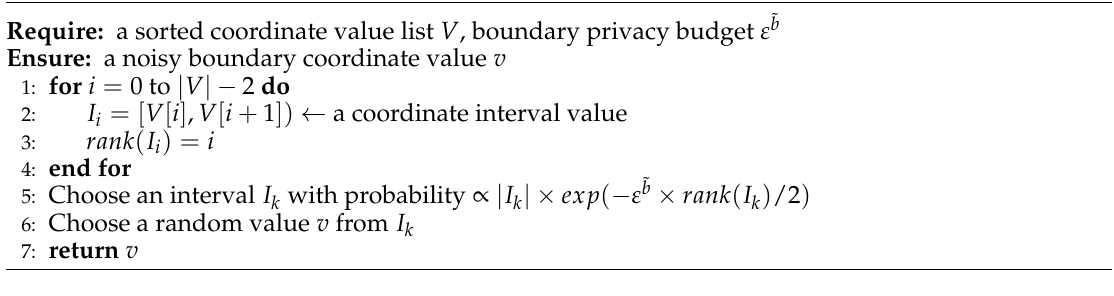
Algorithm 1 BoundaryGeneration procedure.